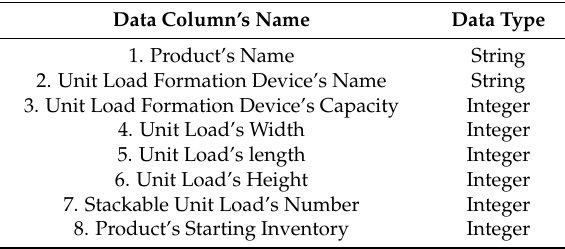
Table 3. Structure of the unit load data table.